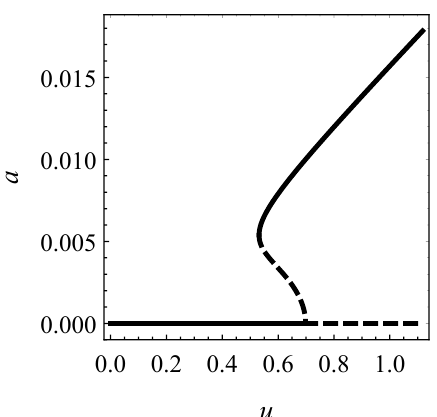
Figure 4. Bifurcation diagram for the case study: steady amplitude of the limit-cycle vs the wind